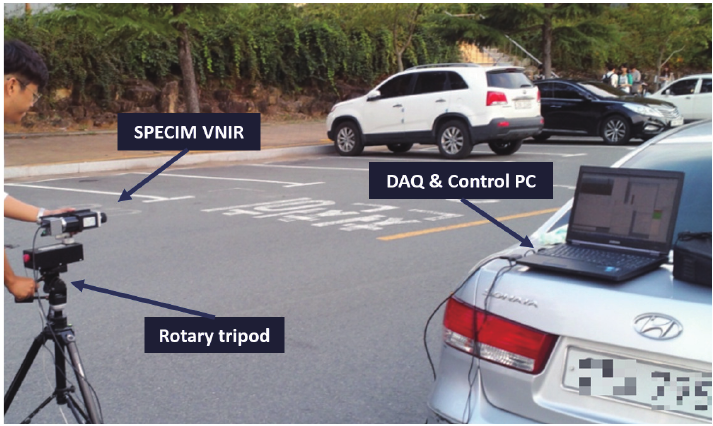
Figure 8. Visible near infrared (VNIR) hyperspectral image acquisition system.